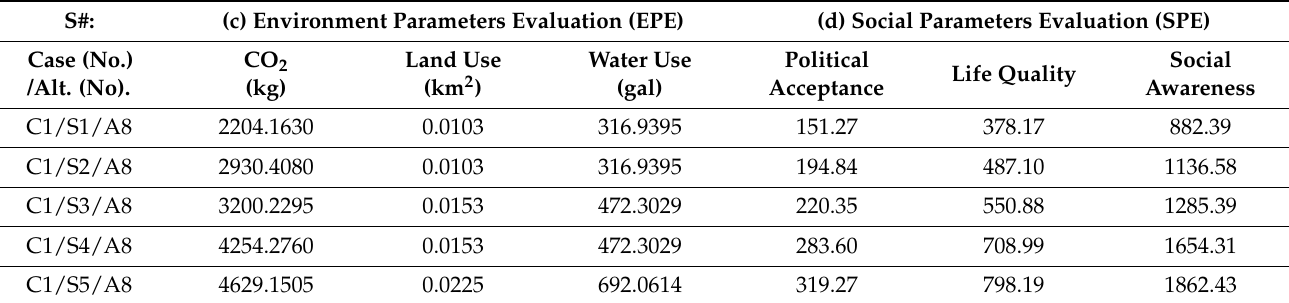
Table 9. Environment-socio (EPE/SPE) evaluations in C1/S1–S5 for the 33-bus